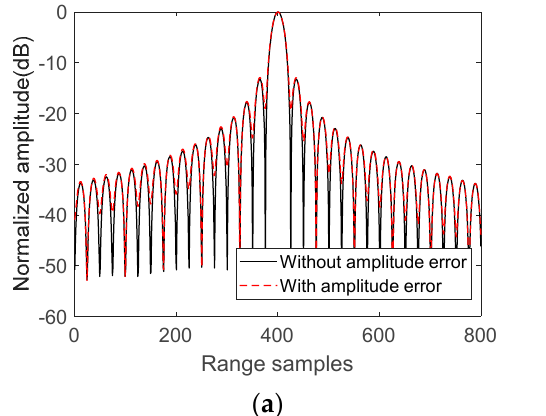
Figure 9. Pulse compression results of the improved DBF processor with multi-frequency time delays ( a ) Pulse compres- sion results with amplitude errors between different frequency sub-bands. ( b ) Pulse compression results with phase errors between different frequency sub-bands. 4. Methodology of Proposed DBF Processor with Multi-Frequency and Multi-Group Time Delays According to the above analysis in Section 3, both improved DBF methods could re- duce the PEL but with unwanted drawbacks. To make full use of the advantages of the two improved DBF methods, a novel DBF processor with multi-frequency and multi- group time delays is proposed in this paper, and its flowchart is shown in Figure 10. In Figure 10, the number of channels, groups of time delay, and sub-bands are N , K , and M , respectively. First, the multi-frequency phase-weighting vectors are multiplied to form sharp receive beams corresponding to different carrier frequencies before the transmitted